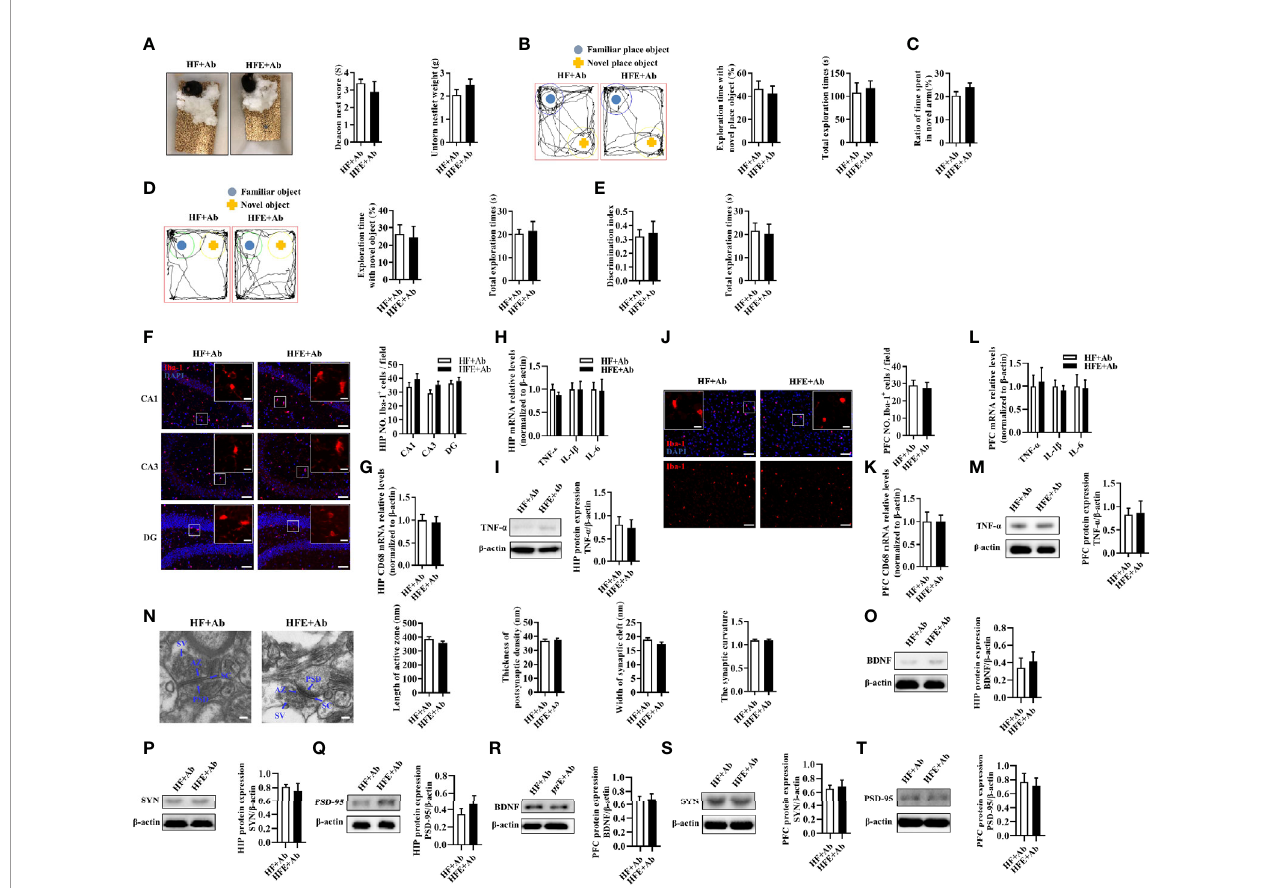
FIGURE 6 | Microbiota ablation with antibiotics eliminated the protective effects of ESPs on cognitive impairment, neuroin fl ammation, and synapse in HF diet- induced obese mice. (A) The nesting behavior test (n =12). (B) The object location test (n =12). (C) The Y-maze memory test (n =12). (D) The novel object recognition test (n =12). (E) The temporal order memory test (n =12). (F) Representative immuno fl uorescent staining and quanti fi cation of Iba-1 + cells in the CA1, CA3, and DG regions of HIP (n = 3, 2 images per mouse, scale bar 50 m m). The image captured from the box was marked with a solid line (scale bar 10 m m). (G, H) The mRNA expression levels of CD68 and proin fl ammatory cytokines, including TNF- a , IL-1 b , and IL-6 in the HIP (n = 6). The relative mRNA levels were normalized with reference gene ( b -actin). (I) The protein expression levels of TNF- a in the HIP (n = 8). (J) Immuno fl uorescent staining and quanti fi cation of Iba-1 + cells in the PFC (n = 3, 2 images per mouse, scale bar 50 m m). (K, L) The mRNA expression levels of CD68 and proin fl ammatory cytokines, including TNF- a , IL-1 b , and IL-6 in the PFC (n = 6). The relative mRNA levels were normalized with reference gene ( b -actin). (M) The protein expression levels of TNF- a in the PFC (n = 8). (N) Representative ultrastructure of synapses in the CA1 region of mice on the electron micrograph (scale bar 100 nm) and image analysis of the length of active zone, thickness of PSD, width of the synaptic cleft, and the synaptic curvature (n = 3, 6 images per mouse). (O – Q) The protein expression levels of BDNF, SYN and PSD-95 in the HIP (n = 8). (R – T) The protein expression levels of BDNF, SYN and PSD-95 in the PFC (n = 8). Values are represented as mean ±